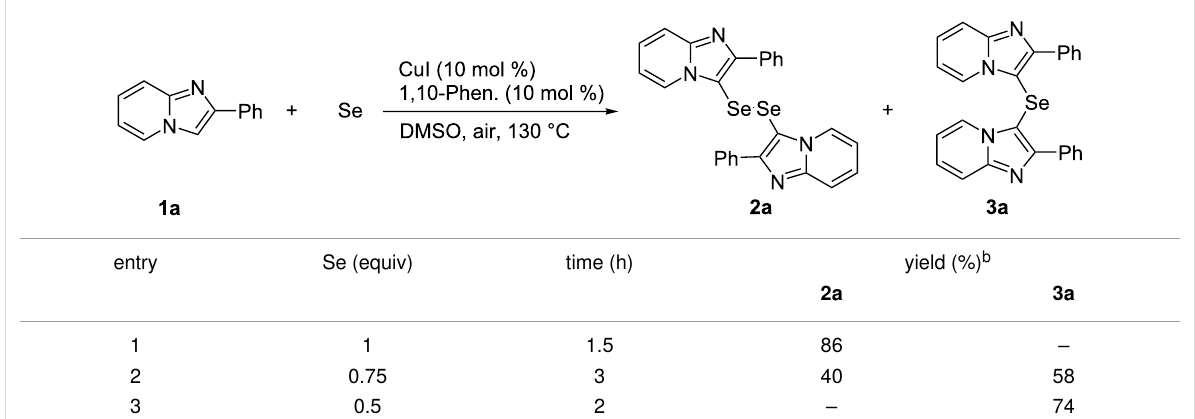
Table 1: The reaction of 2-phenylimidazopyridine with Se powder. a